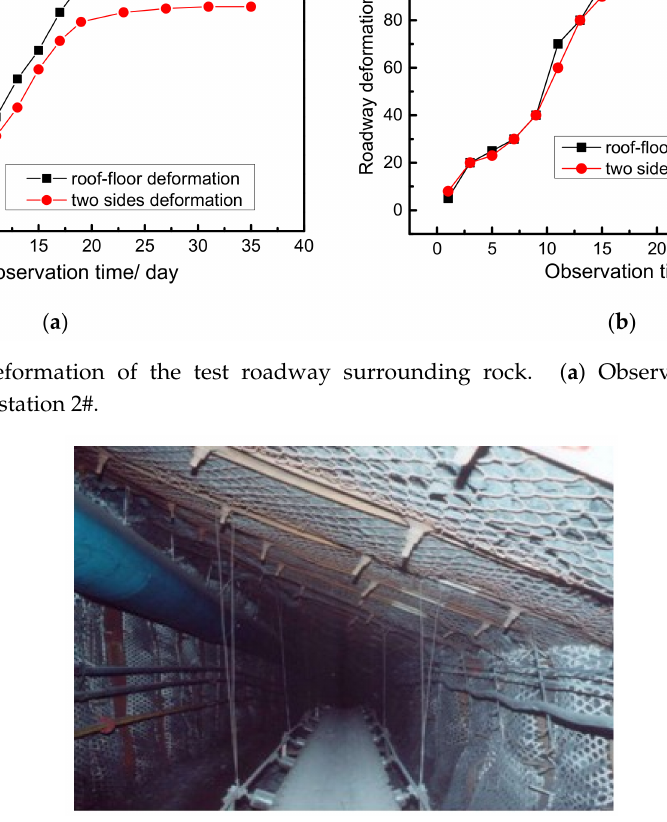
Figure 17. Test roadway after the stability of the surrounding